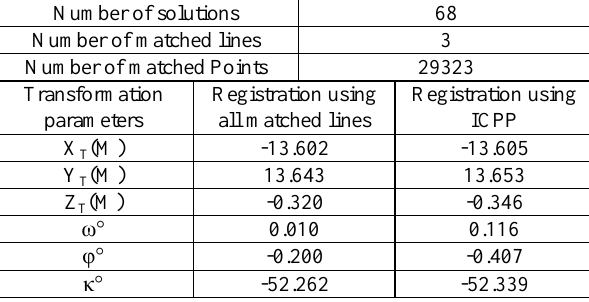
Table 4 Automatic registration results for scans 62 and